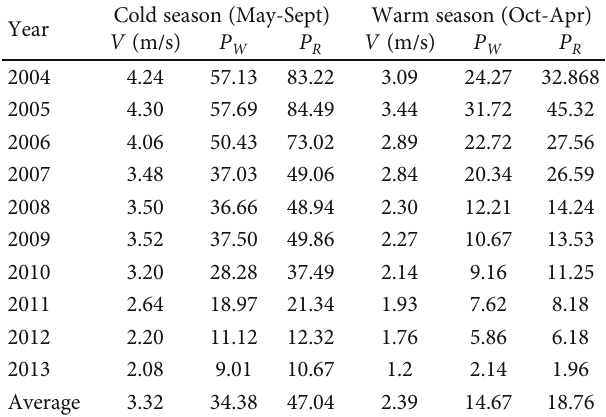
Table 4: Yearly mean wind speed and power for cold and warm seasons of the Kisii region (Tables 33 and 34 in Supplementary